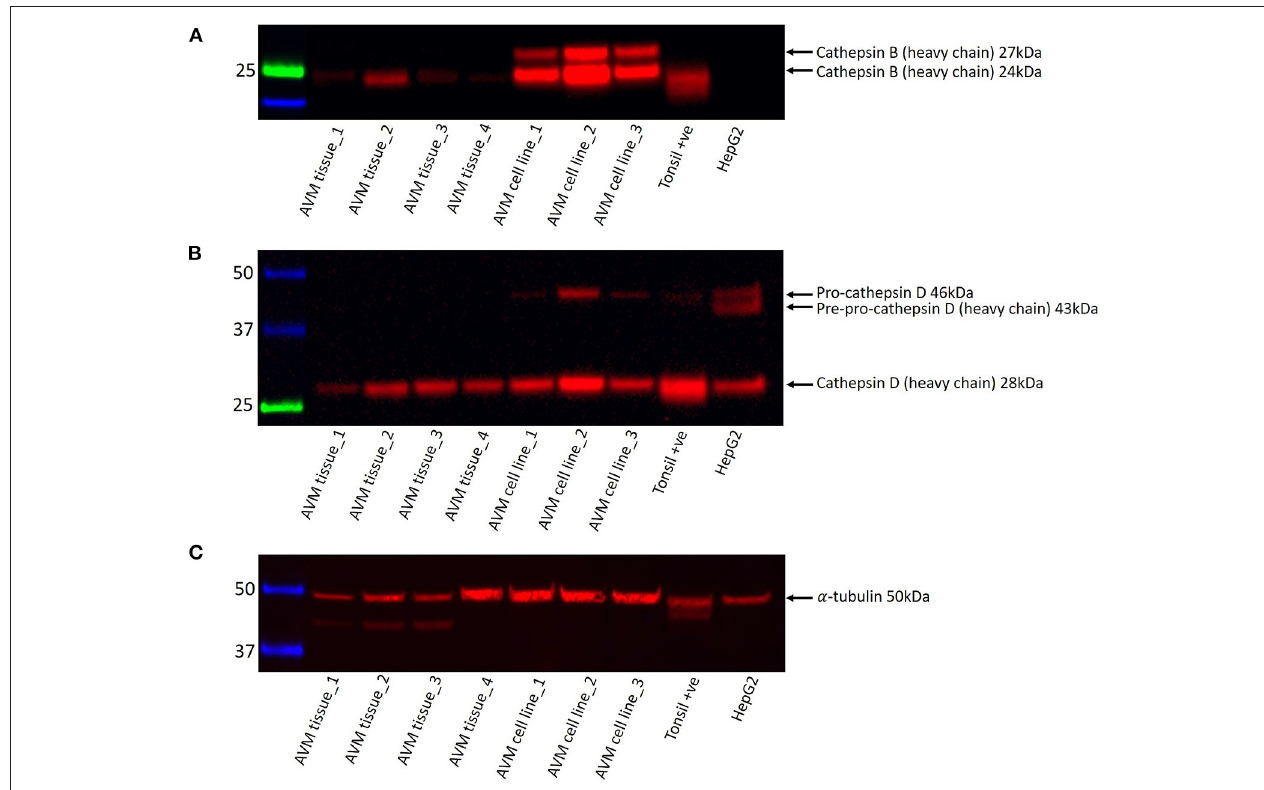
FIGURE 2 | Representative western blot images of total protein extracted from four arterio-venous (AVM) tissue samples and three AVM-derived primary cell lines probed for cathepsins B and D. Cathepsin B (A) , cathepsin D (B) , and α -tubulin (C) were present at the appropriate molecular weights, as labeled.